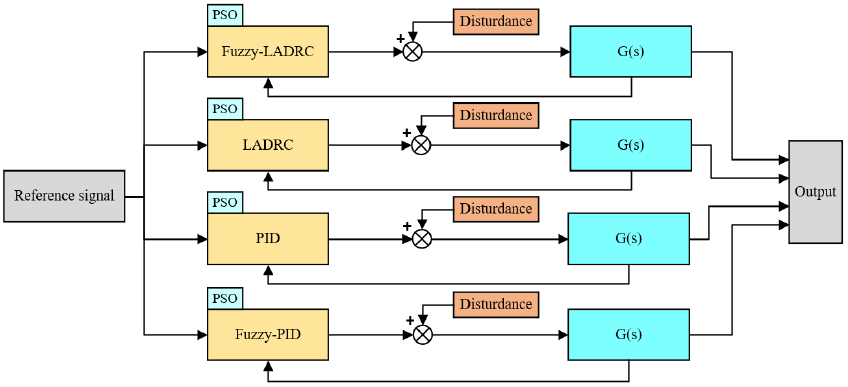
Figure 6. The structure of comparative experiment of four controllers.